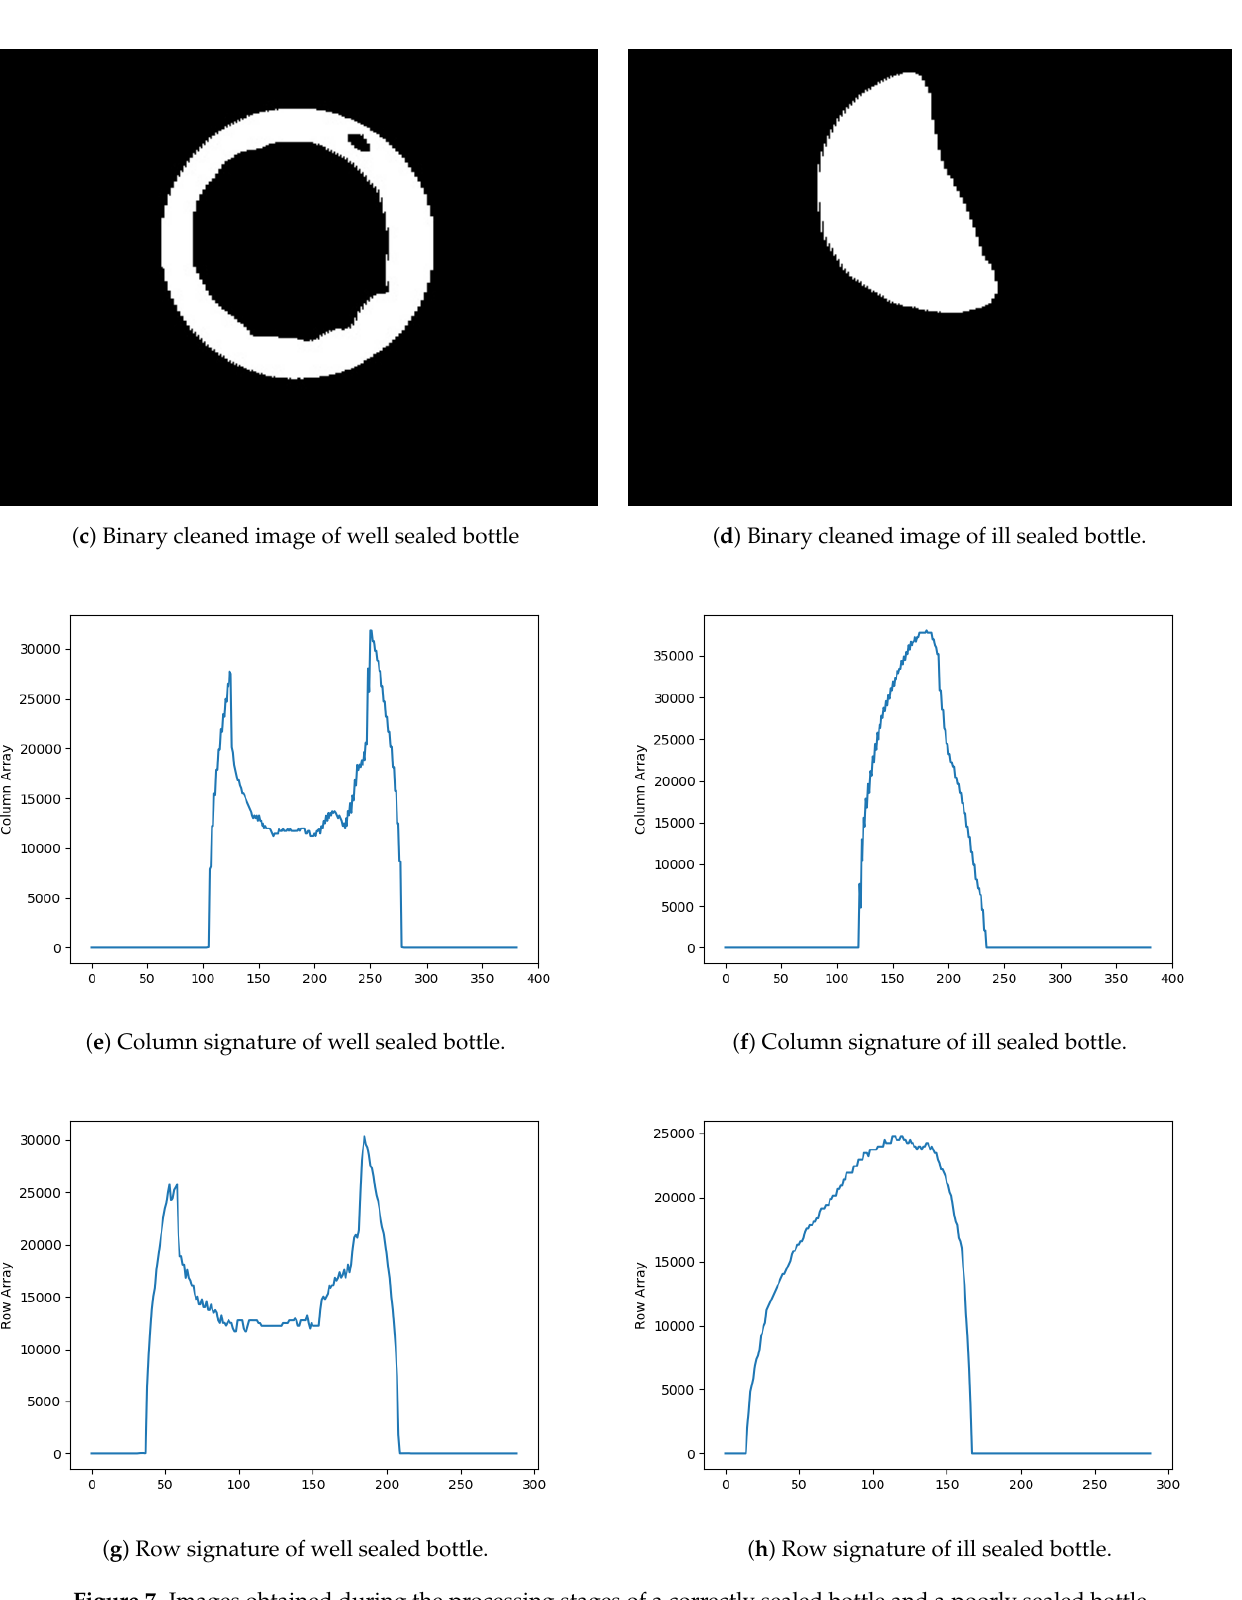
Figure 7. Images obtained during the processing stages of a correctly sealed bottle and a poorly sealed